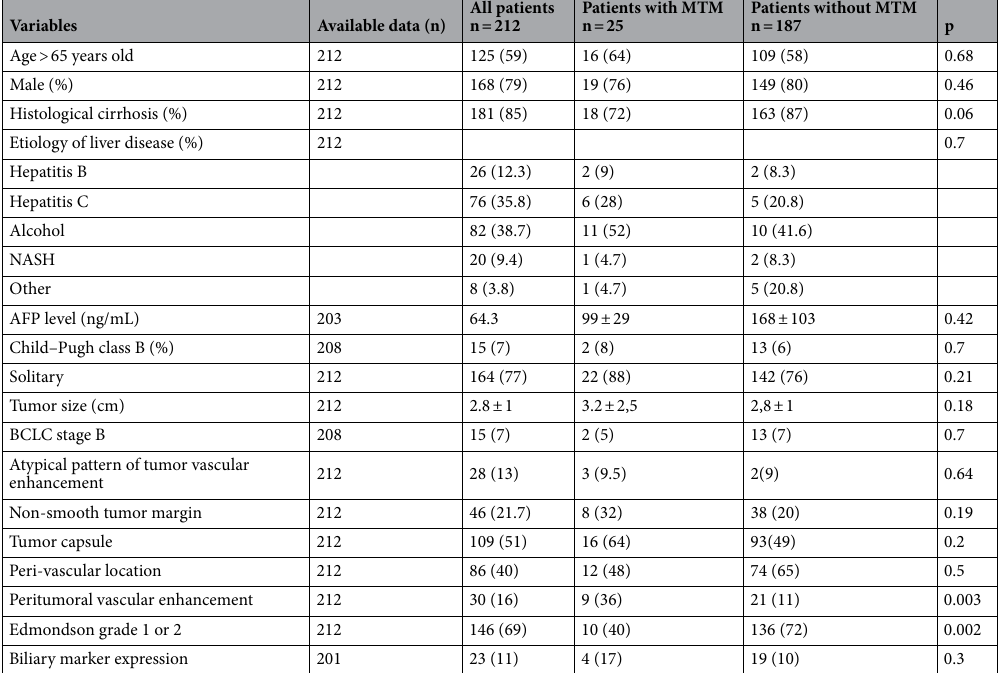
Table 4. Baseline clinical and imaging characteristics associated with macrotrabecular-massive subtype. Statistical analysis were performed using the Mann–Whitney test and the Fisher exact test. AFP, alphafoetoprotein level; BCLC, Barcelona Clinic Liver Classification; HR, hazard ratio; MTM, macrotrabecular massive subtype at histology; NASH, non-alcoholic